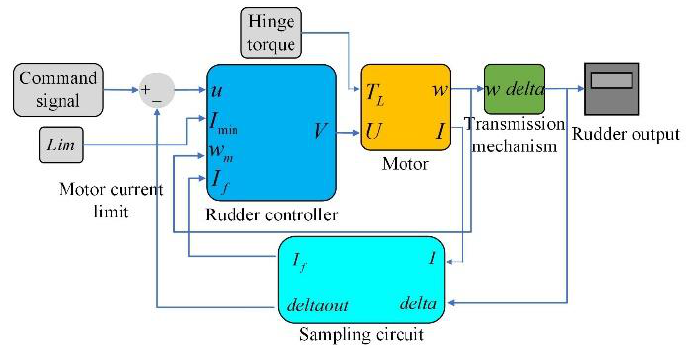
Figure 6. The scheme of matrix laboratory (MATLAB)/Simulink. Table 1. Physical parameter of electric rudder system.